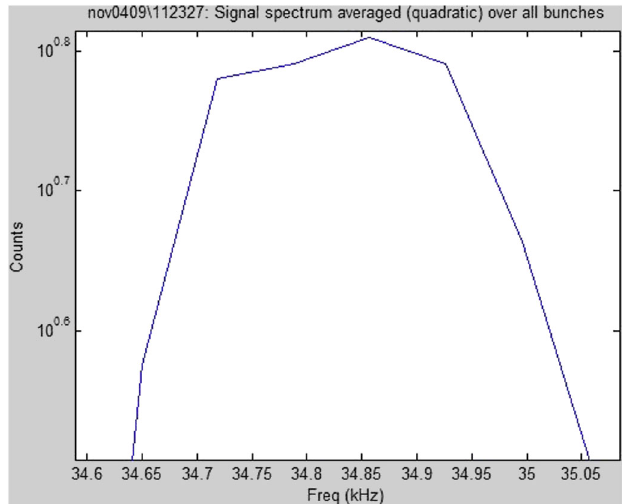
FIG. 6. The average synchrotron frequency (off collision) is 34.86